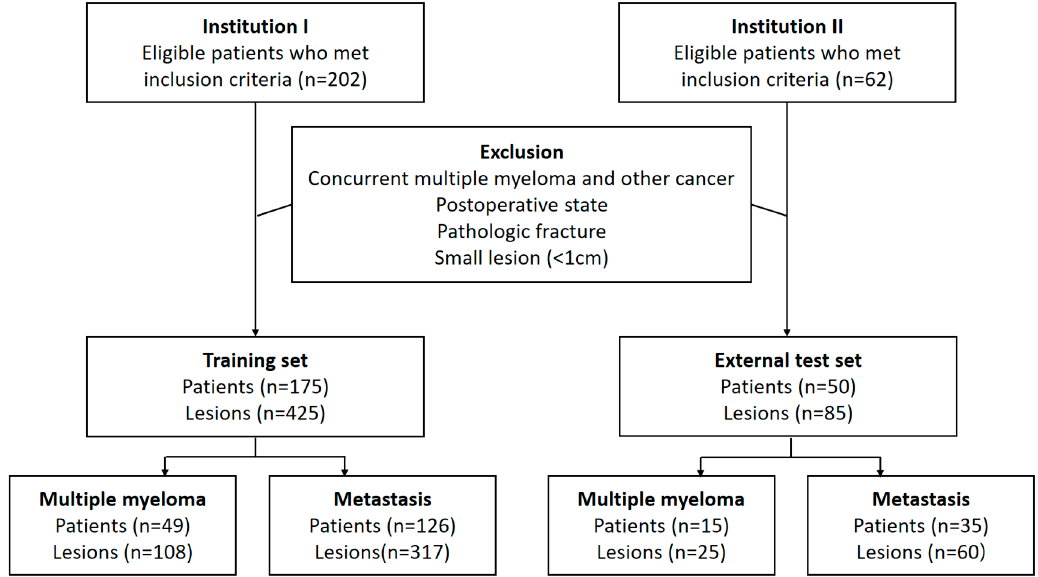
Figure 1. Flowchart showing inclusion and exclusion criteria of patients.